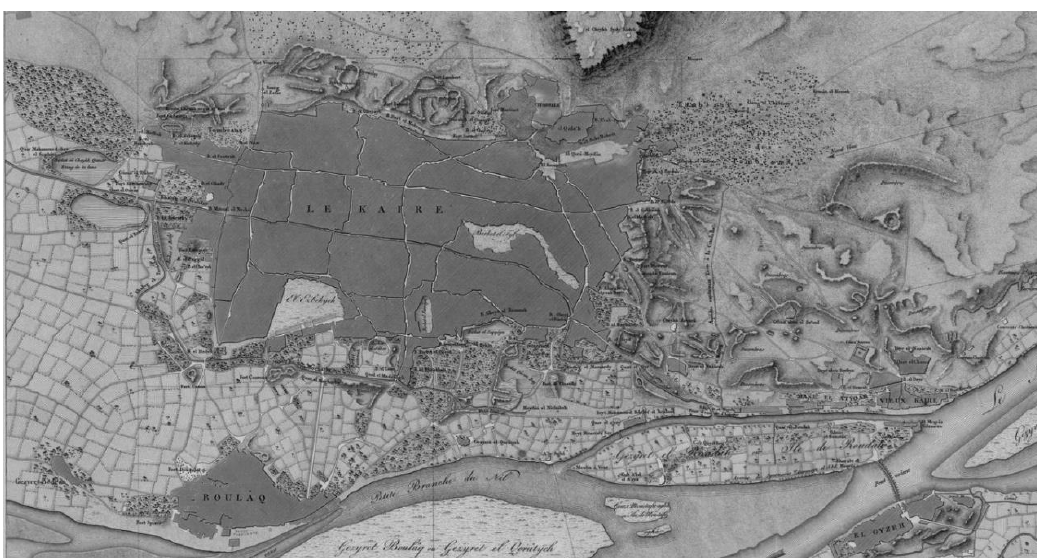
Figure 2: Chamouin et Dandeleux Vol.I. PL.15, 1829, Description de l'Égypte État Moderne,